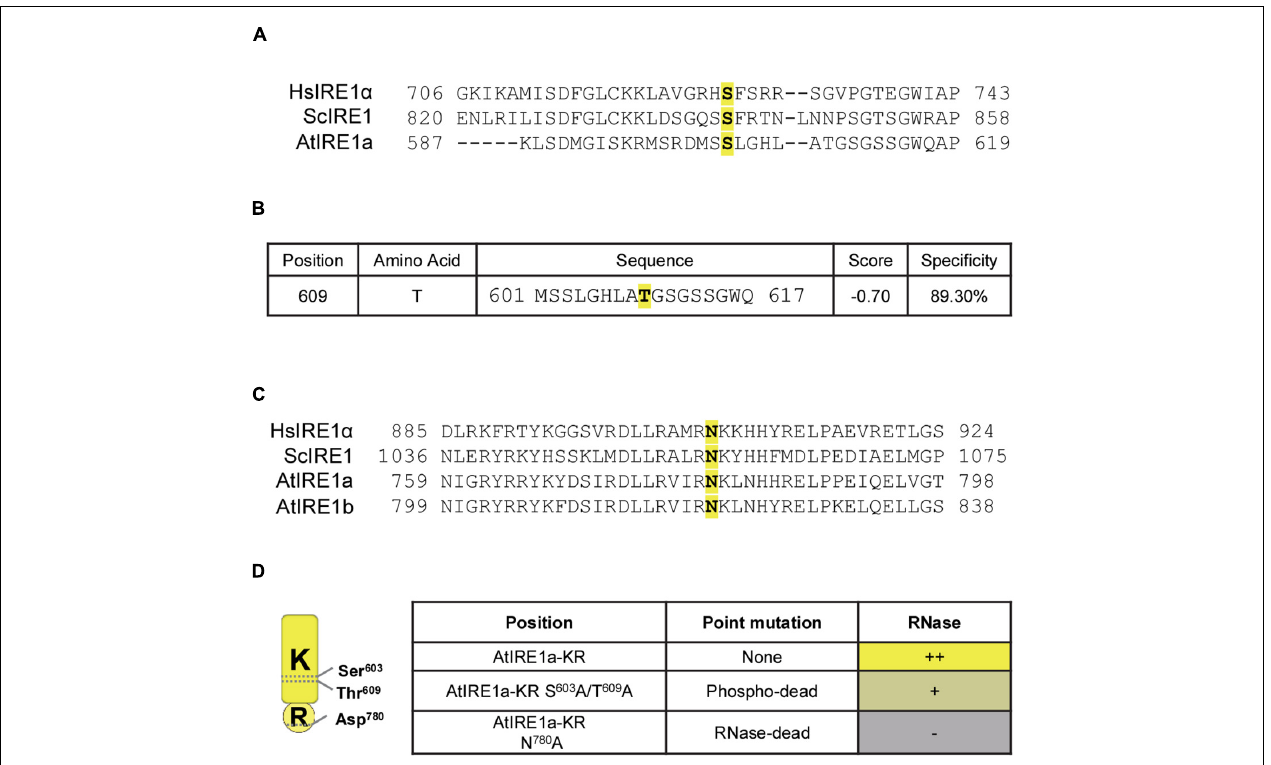
FIGURE 2 | Identification of conserved amino acid sites important for AtIRE1a RNase function. (A) Multiple sequence alignment of IRE1 proteins. Partial sequences of Homo sapiens IRE1 α (HsIRE1 α ), Saccharomyces cerevisiae IRE1 (ScIRE1), and AtIRE1a were aligned using Clustal Omega (https://www.ebi.ac.uk/Tools/msa/clustalo/). The conserved Serine residue is highlighted in yellow with bold font; (B) Prediction of plant-specific phosphorylation sites on AtIRE1a. The amino acid sequence of AtIRE1a was used to predict the phosphorylation sites using Musite (http://musite.sourceforge.net/). The conserved Threonine residues are highlighted in yellow with bold font; (C) Multiple sequence alignment of IRE1 proteins to map the conserved RNase domain residues. HsIRE1 α , ScIRE1, AtIRE1a, and AtIRE1b partial protein sequences were aligned using Clustal Omega. The conserved Asparagine important for the IRE1 RNase activity is highlighted in yellow with bold font; (D) Conserved domain architecture of the Arabidopsis IRE1a KR protein domain, indicating critical amino acid residues and point mutations influencing the RNase activity. Relative levels of RNase activity detected in our experiments are indicated with (+) and (–)